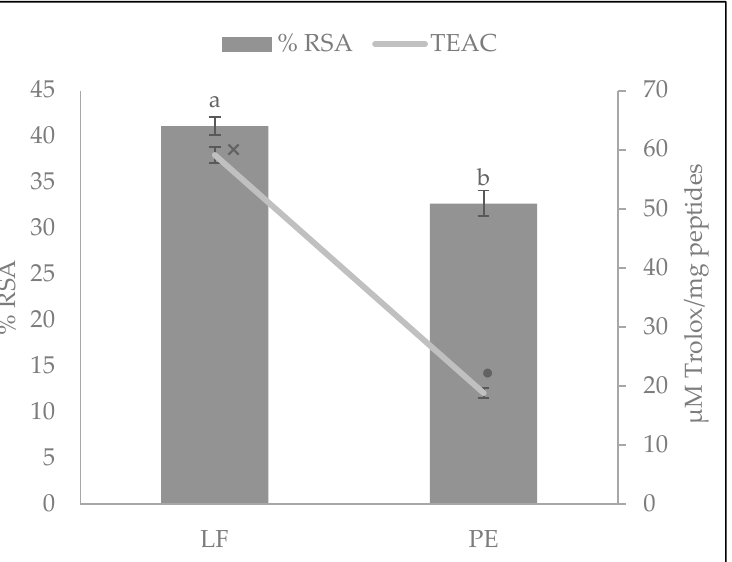
Figure 1. Antioxidant activity of A. diaperinus larvae flour (LF) and its protein extract (PE) hydrolysates against 1,1-Diphenyl-1-pycrylhydrazyl (DPPH) radical. Bars show the radical scavenging activity percentage (RSA%) and the line represents the Trolox equivalent activity capacity (TEAC: µM of Trolox equivalents per mg of peptides). Values are mean ± SD ( n = 3). Bars with different letters (a, b) and TEAC values (line) with distinct symbols (×, • ) were statistically different ( p < 0.008 and p < 0.001, respectively).